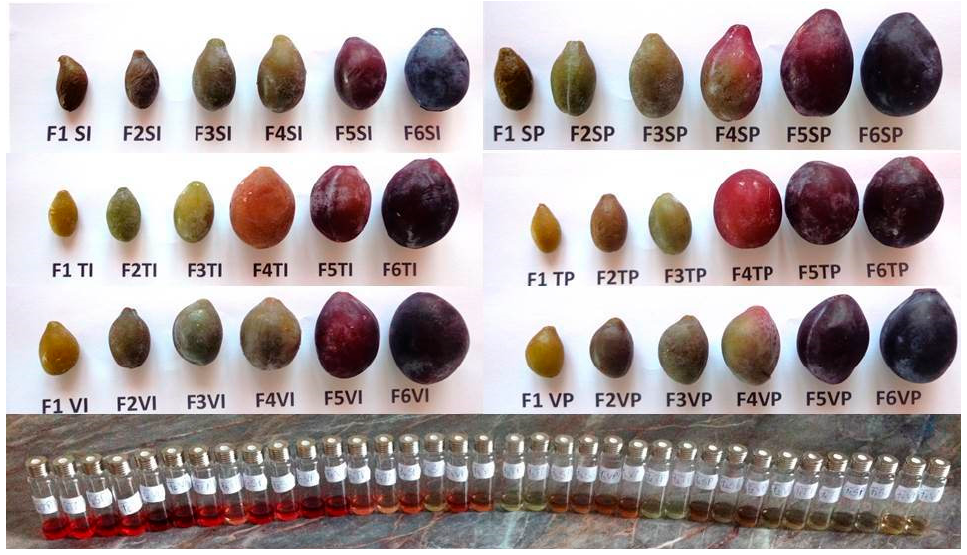
Figure 1. The samples used in the experiment (F1 → F6—Harvesting phases; S—“Stanley”; T—“Tuleu Gras”; V—“V â n ă t de Italia”; P—Periphery of the tree crown; I—Inside of the tree crown).